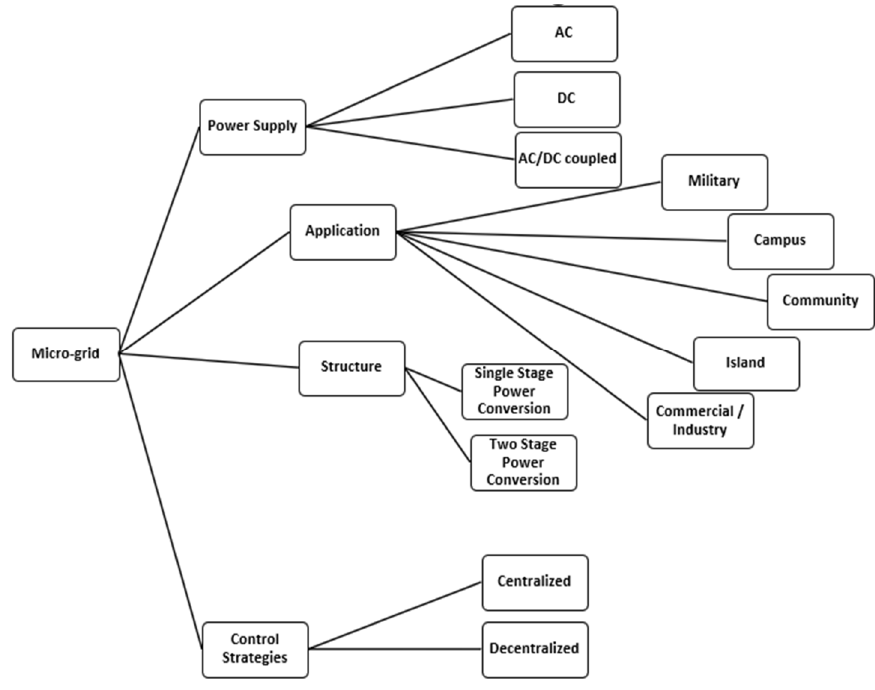
Figure 1. Microgrid categorization [16].